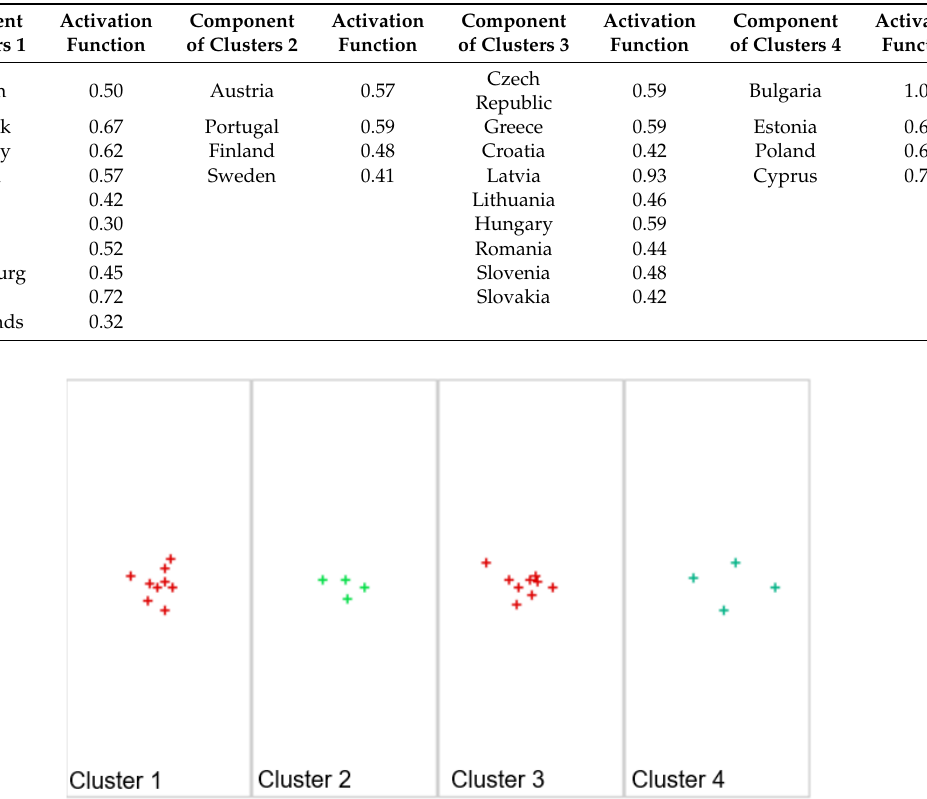
Figure 7. Topological map of clusters of similar EU-27 countries in terms of the values of sustainable energy indicators versus the gross domestic product value.